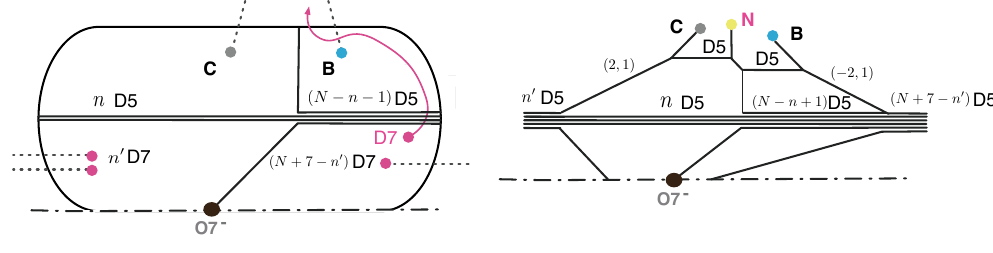
Figure 11 . 5d SU( N + 1) 0 gauge theory with N f = N + 7 and N a =